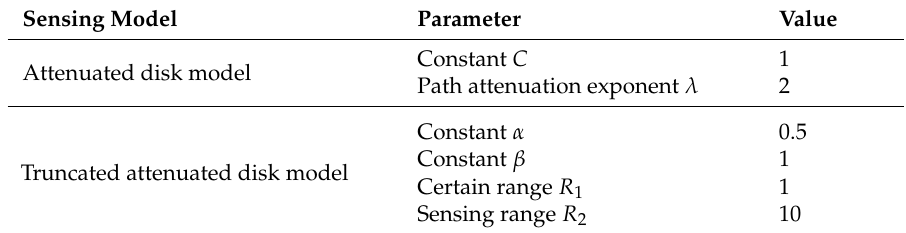
Table 2. Experimental parameters for attenuated disk model and truncated attenuated disk model.